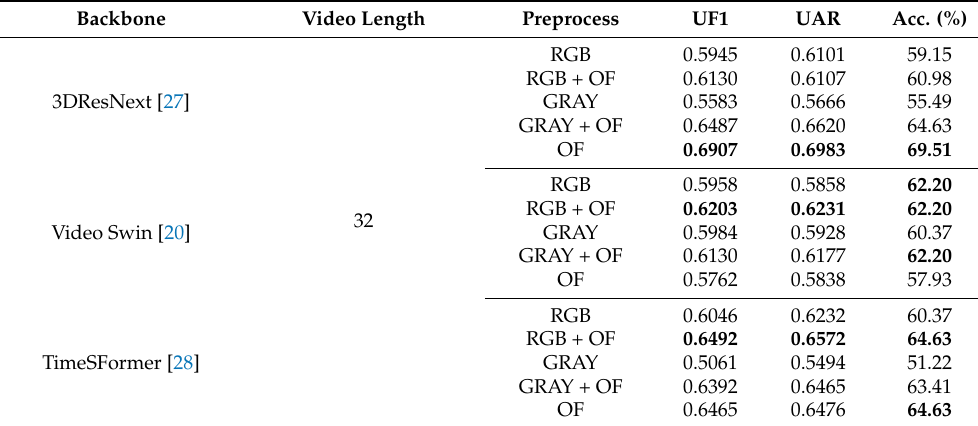
Table 4. Comparison between using optical flow and